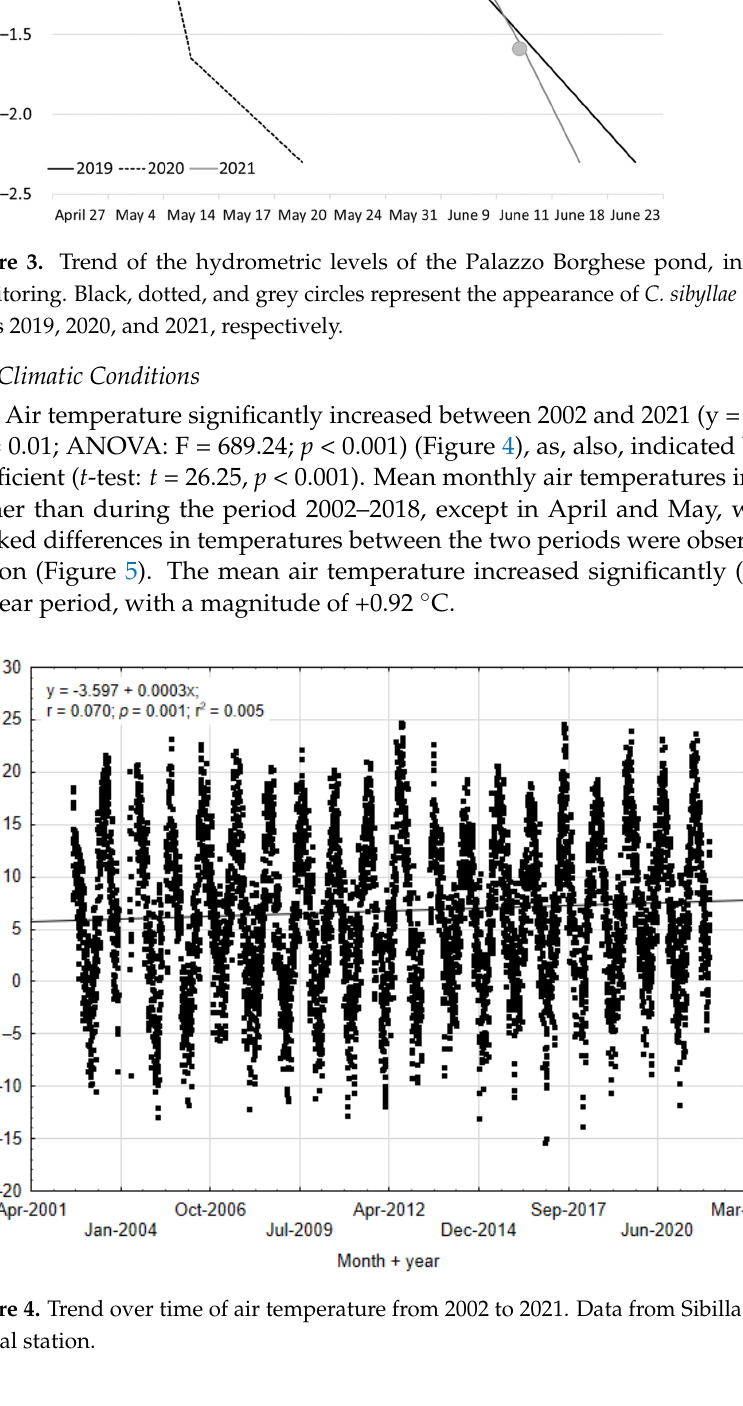
Figure 5. Mean monthly air temperature for the years 2019–2021, and comparison with the period 2002–2018. Data from Sibilla Mountain meteorological station. 3.3. Composition of the Zooplankton Community The zooplankton community of the Palazzo Borghese pond was composed of a limited number of species. In addition to the Anostraca, represented by C. sibyllae , another four zooplankton taxa were identified: two Ostracoda species in two genera, Herpetocypris reptans and Cyclocypris sp., one cladoceran species, Chydorus sphaericus (Müller, 1776) (Chydoridae), and one copepod species, Diacyclops bisetosus (supplementary material: Table S2). In 2019, Copepoda appeared in the sampling in April, together with Anostraca, and, subsequently, during the two samplings in May, they constituted most of the zooplankton community, accounting for 81% and 95% of sampled individuals of all taxa, respectively. In June, the most represented taxon was Anostraca (91%). In this year, Cladocera were